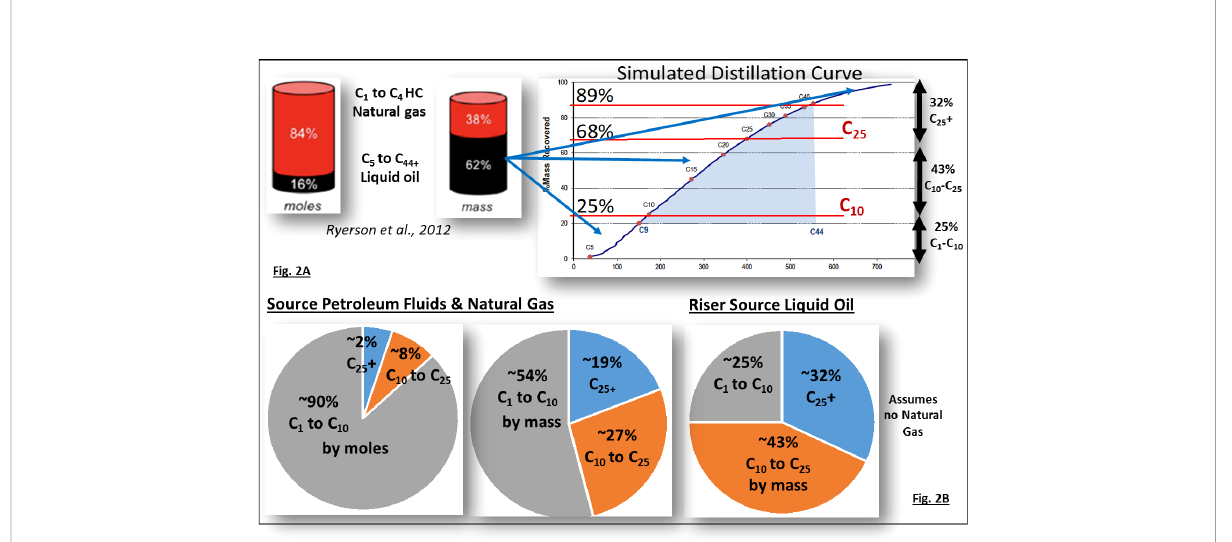
FIGURE 2 Bulk composition of petroleum compounds released into the deep-water environments by the blowout of the Macondo well in 2010, showing the relative proportions of Natural Gas (C 1 to C 4 +) and Liquid Oil (C 5 to C 44 plus resins and asphaltenes) on a molar and weight basis. Further, in (B) , the source petroleum and surface liquid oil ’ s composition is partitioned between gaseous and volatile components (C 1 to C 10 ), readily degradable labile hydrocarbons (C 10 to C 25 ), and insoluble recalcitrant mostly solid material containing hydrocarbons larger than C 25 (C 25 +) as calculated with compositional data provided in Ryerson et al., 2011; Ryerson et al., 2012 and Stout et al.,